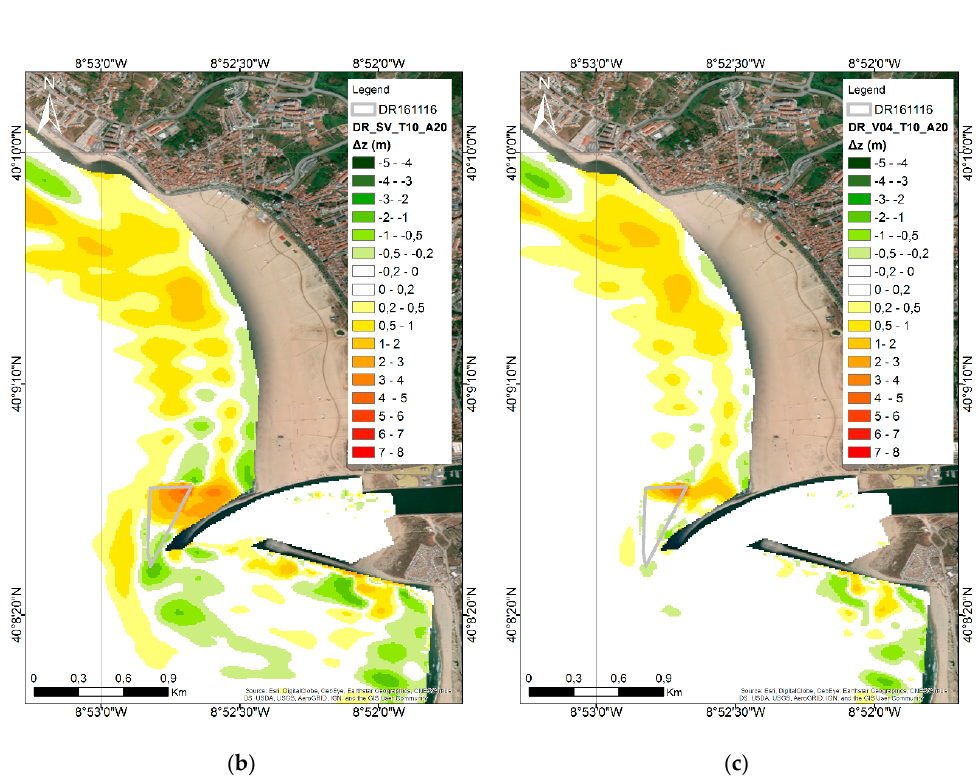
Figure 3. Bathymetry di ff erences between November 2016 and December 2016: ( a ) observed, ( b ) modeled with the Soulsby-Van Rijn sediment transport equation, ( c ) modeled with Van Rijn sediment transport equation. Note: the polygon with grey border corresponds to the dredged area in November